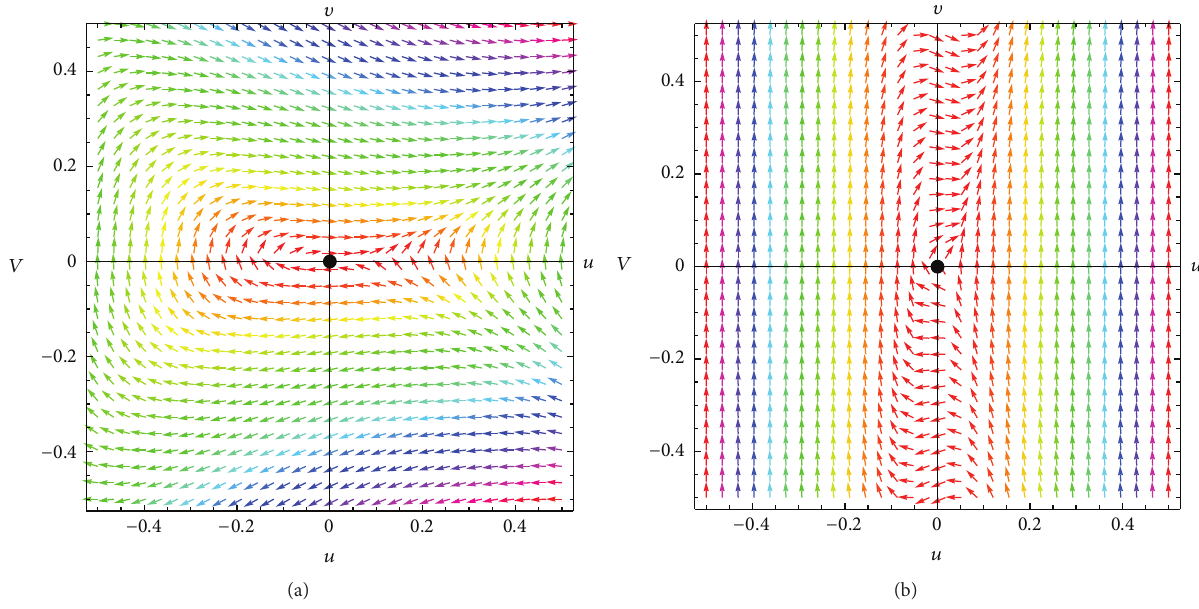
Figure 3: Plot of the phase trajectories for system (25) with M = 1 (a) and M = 10 (b) with 𝛽 = 𝑛 = 1